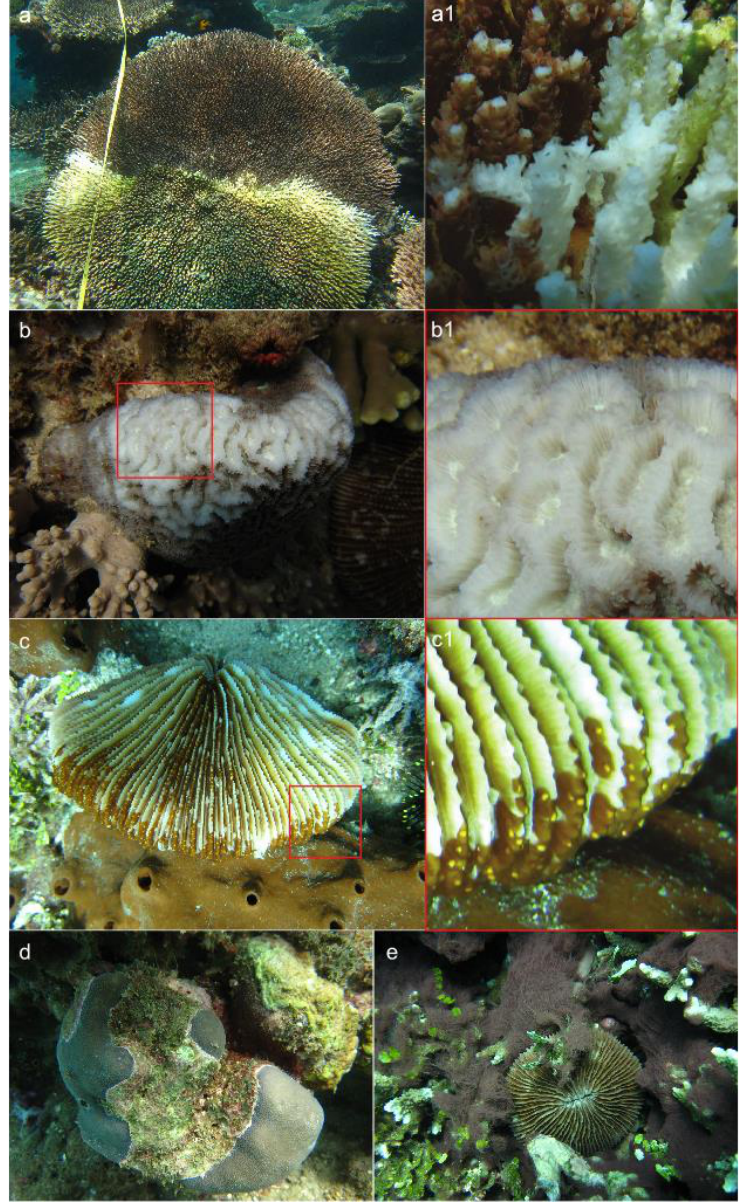
Figure 2. Examples of disease and compromised health recorded on surveys undertaken in Timor- Leste between 15–27 November 2015. Photos outlined in red represent close-ups of adjacent photos ( b1 , c1 ). ( a ) WS–White Syndrome band of distinct tissue loss on tabulate acroporids with white skeleton abutting live tissue with exposed skeleton gradually colonized by turf algae, ( a1 ) exposed coral skeleton caused by coral tissue loss from WS, ( b ) bleached tissue displaying white, living tissue lacking symbionts, ( c ) flatworm infestation on a Fungia coral, ( d ) turf algae overgrowth on a massive Porites coral, and ( e ) cyanobacterial (purple) overgrowth on a reef affecting more than one genus (i.e., Fungia and branching montiporids). See Figure S1 for other compromised states and Table S3 for more